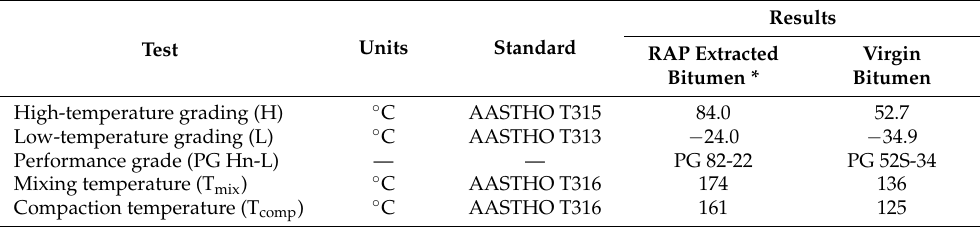
Table 2. Reclaimed asphalt pavement (RAP) and virgin bitumen properties.